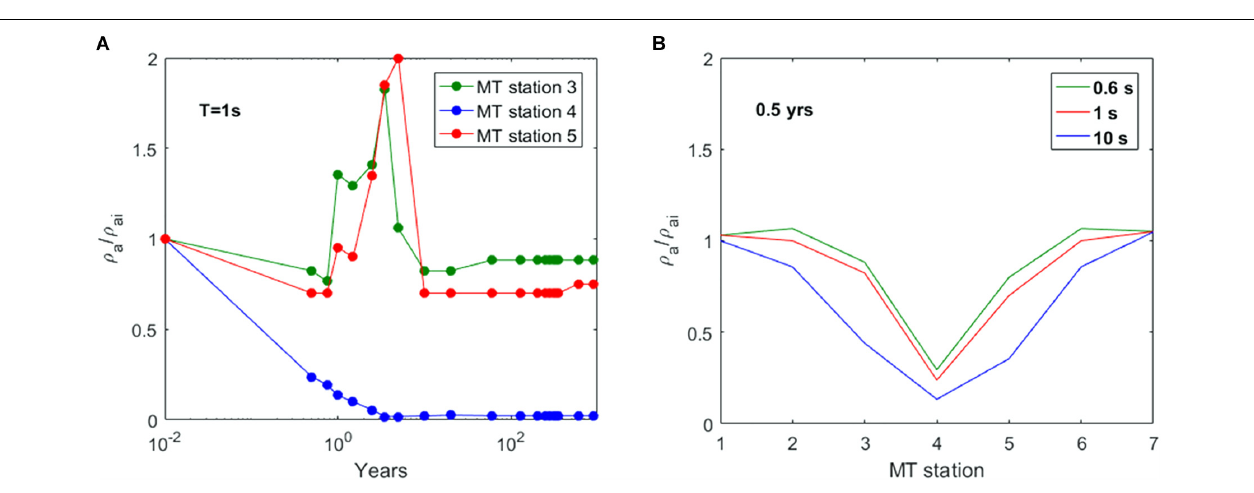
FIGURE 11 | Scenario II. (A) Ratio between the synthetic apparent resistivity values and the initial resistivity value, estimated for the three central MT stations as a function of time at the fixed period T = 1 s. (B) Ratio between the synthetic apparent resistivity values and the initial resistivity value estimated after a simulation time of 0.5 years for the seven MT stations at three fixed